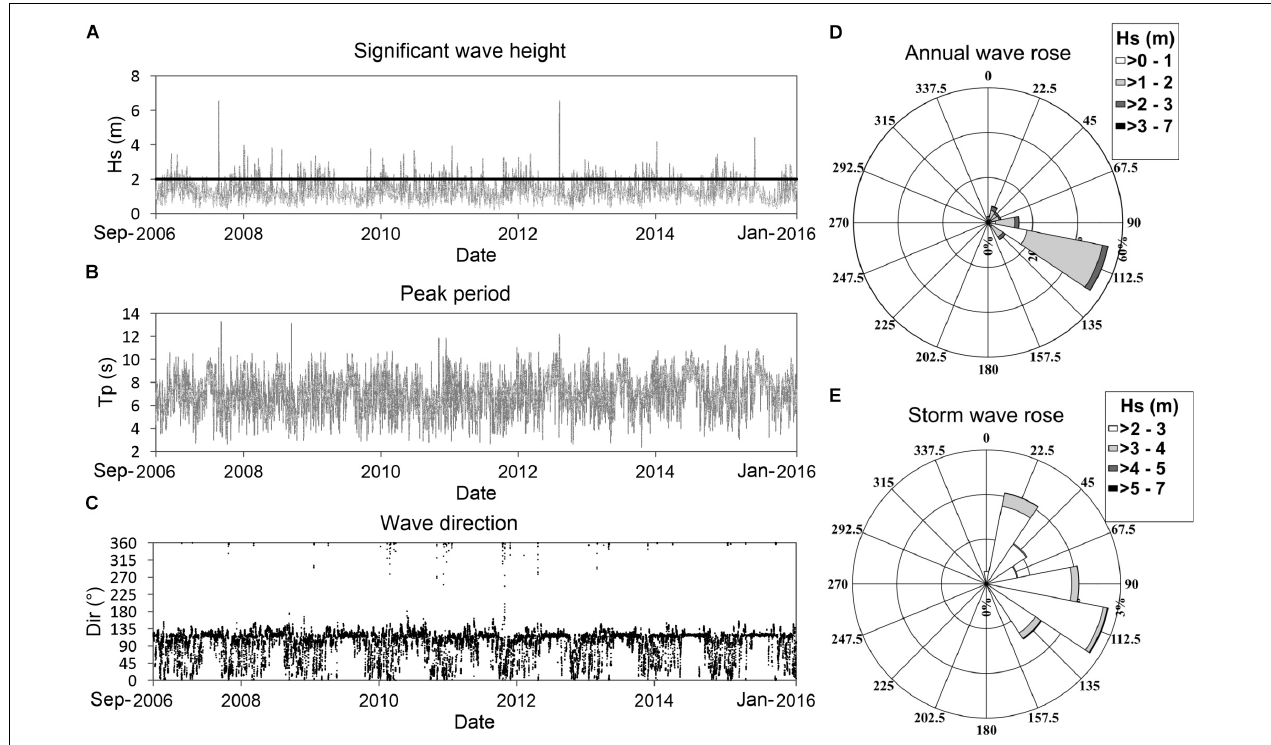
FIGURE 5 | Time series of reanalysis data and wave roses: (A) Significant wave height (m), the horizontal line represents the storm threshold; (B) peak period (s); (C) wave direction (degrees from North); (D) wave height rose (entire data set); and (E) wave rose (only